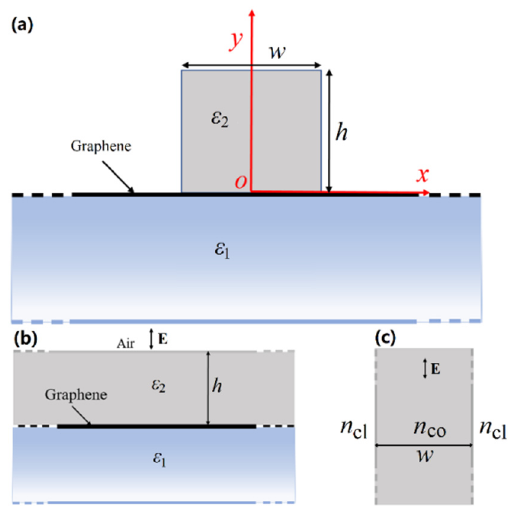
Figure 1. ( a ) Cross-section of the DLGSPWG structure. ( b ) The equivalent four-layer and ( c ) three- layer structures considered in the EIM.